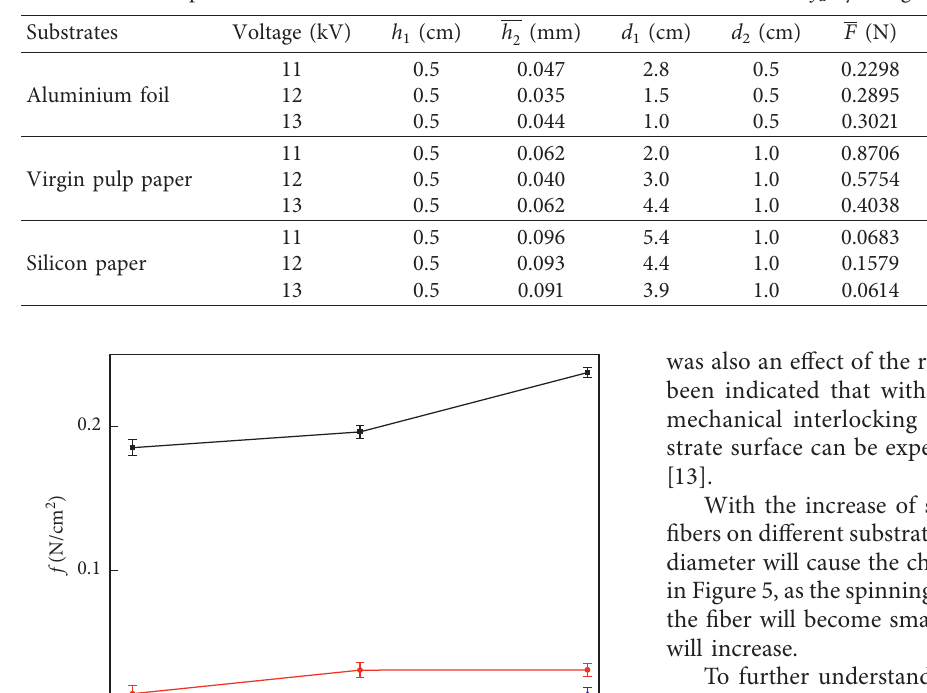
a by using the home-made pulling system.